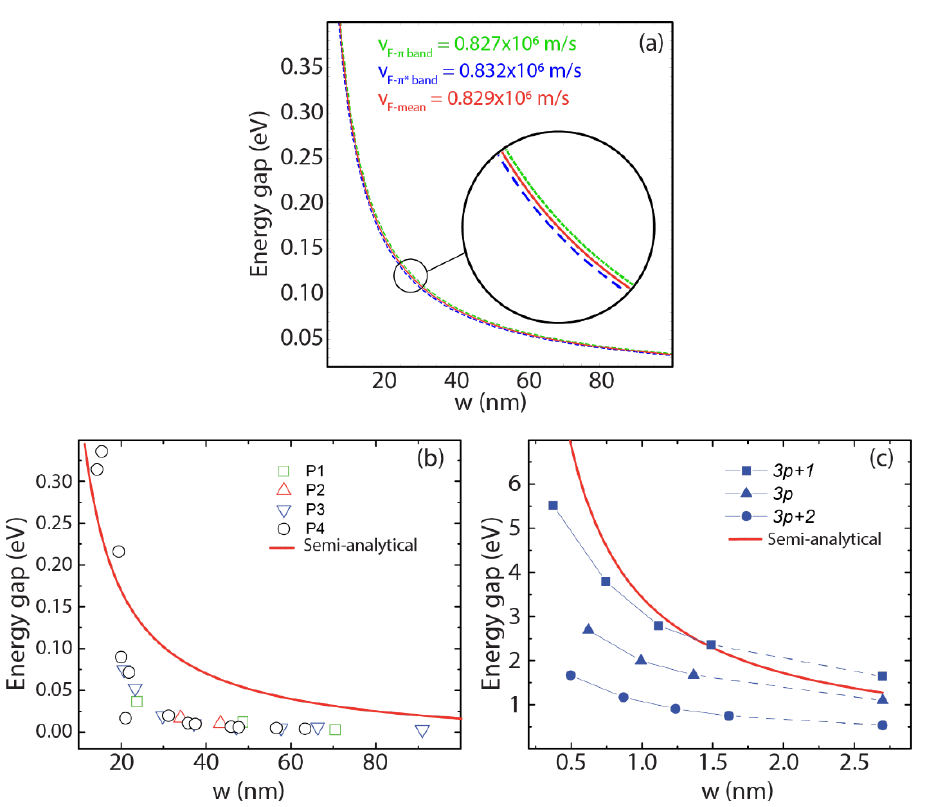
Figure 5. Energy gap ( Δ ) as a function of the ribbon width ( 𝑤 ). ( a ) The dotted green line is obtained using the DFT group velocity of the 𝜋 band ( v π = 0.827 × 10 6 m/s); the dashed blue line using the DFT group velocity of the 𝜋 ∗ band ( v π ∗ = 0.832 × 10 6 m/s); the red solid line using the average group velocity ( v F = 0.829 × 10 6 m/s). ( b ) Bandgap variation is obtained using Equation (4) and v F = 0.829 × 10 6 m/s (red solid line), and compared to the band gaps measured on GNRs as taken in Ref. [48] (P1 – P4 refers to 4 different datasets). ( c ) Bandgap variation using Equation (4) and v F = 0.829 × 10 6 m/s (red solid line) compared to the band gaps predicted by the GW approximation for different families of GNRs, as taken from Refs. [29,51].